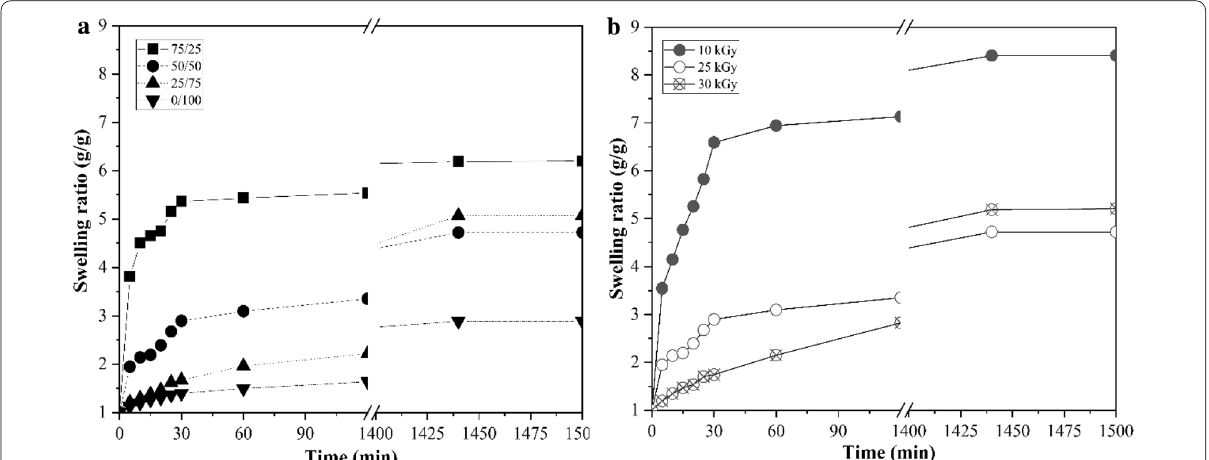
Fig. 2 Swelling ratio (g/g) vs. time (min) graph of the prepared hydrogels in deionized water at different polymer ratios a and radiation doses of 50/50 CS/PVA hydrogel